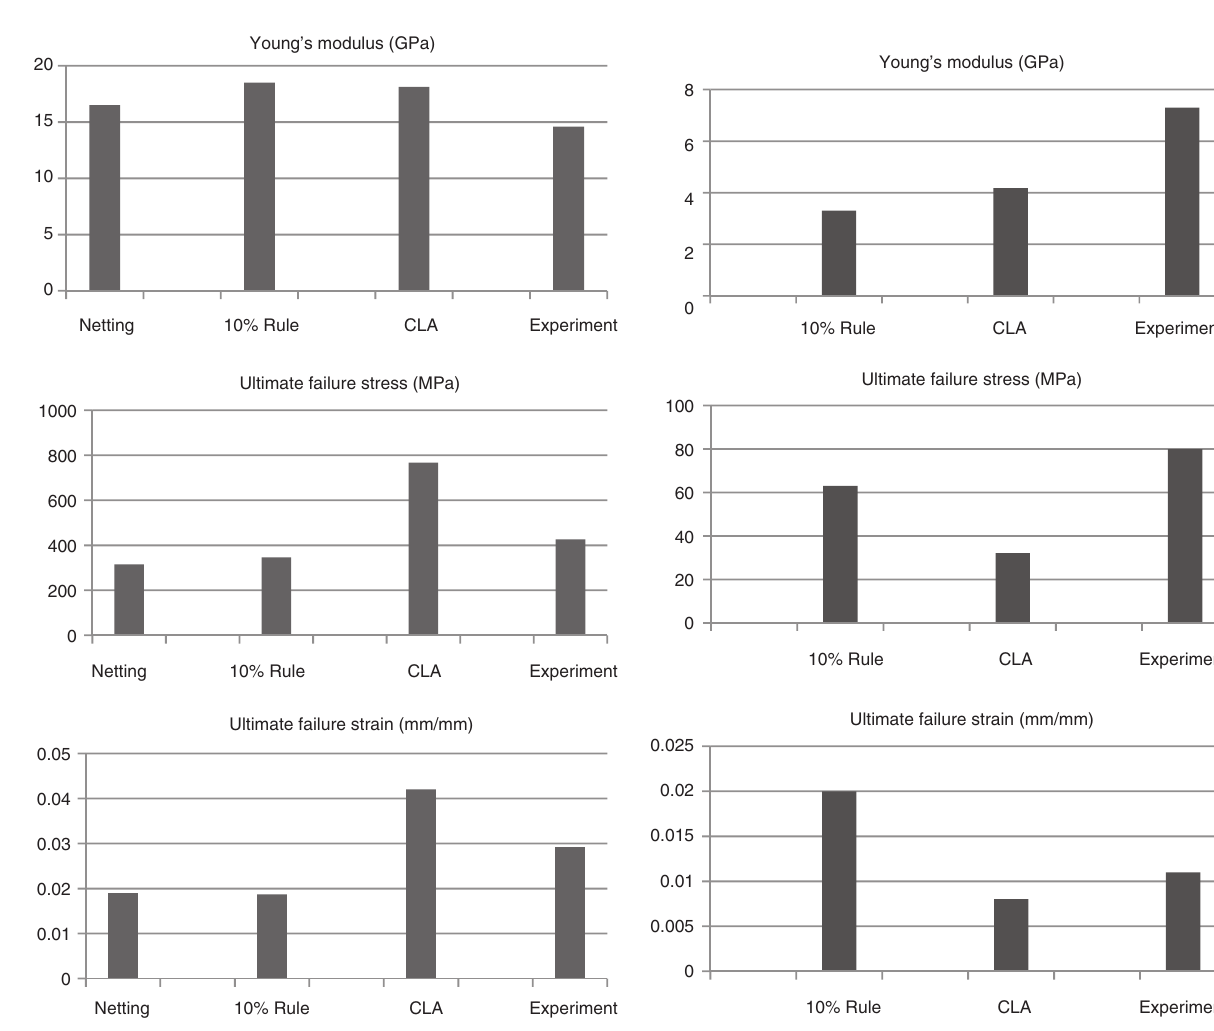
, -67.5 ] comparison results. 4 4 s